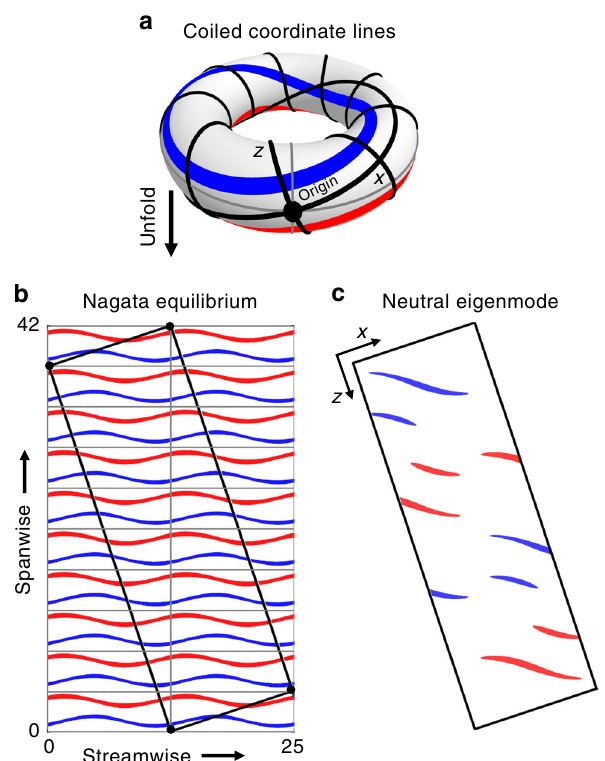
Fig. 2 Eigenvalue spectrum characterizing the linear stability of the stripe equilibrium. Shown are the 100 leading eigenvalues in the complex plane ( ω r , ω i ), computed by Arnoldi iteration at Re = 350 33 . 15 eigenvalues with a positive real part ω r > 0 quantify the exponential growth rate ω r along the unstable directions in the linear eigenspace of the stripe equilibrium. The imaginary parts ω i quantify the oscillatory frequencies in the eigenspace and the absolute values indicate typical turbulent time scales in the fl ow in units of U / h . The wide aspect ratio of the spectrum (uniform axes) graphically illustrates that the maximum growth rate ω r = 0.034 is small compared to the typical turbulent time scales. The stripe equilibrium shown NATURE COMMUNICATIONS| (2019) 10:2277